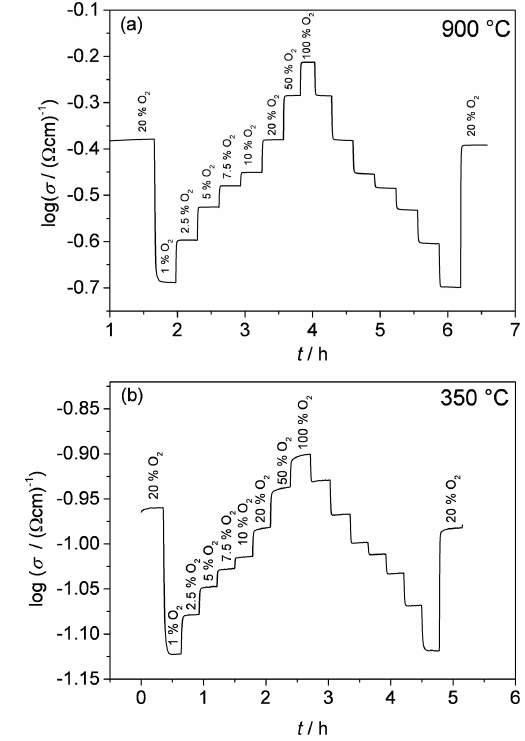
Figure 4. Conductivity of the BFT30 sensor as a function of p O 2 (a) at 900 ◦ C and (b) at 350 ◦ C.